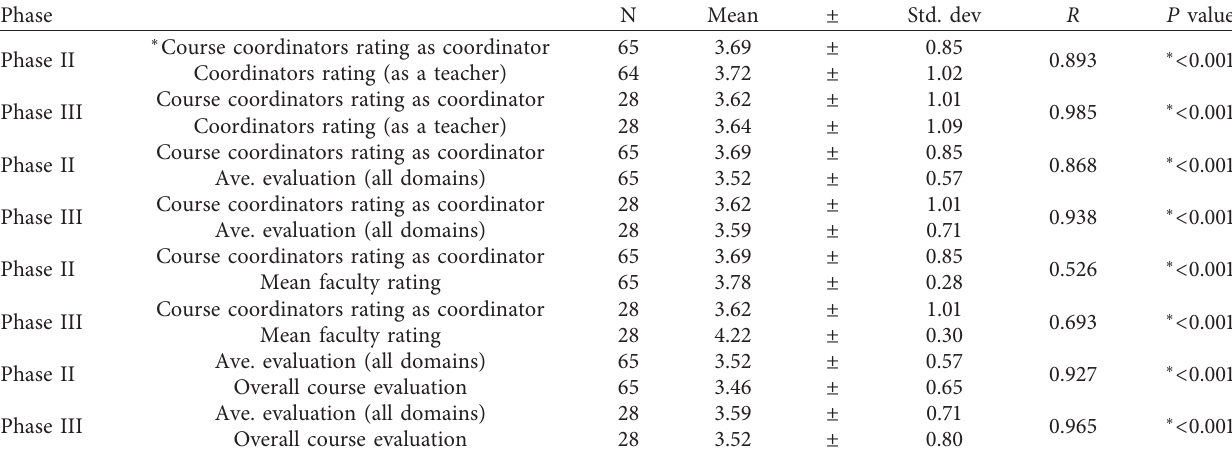
Table 4: Association and difference based on the level of study, that is, preclinical and clinical